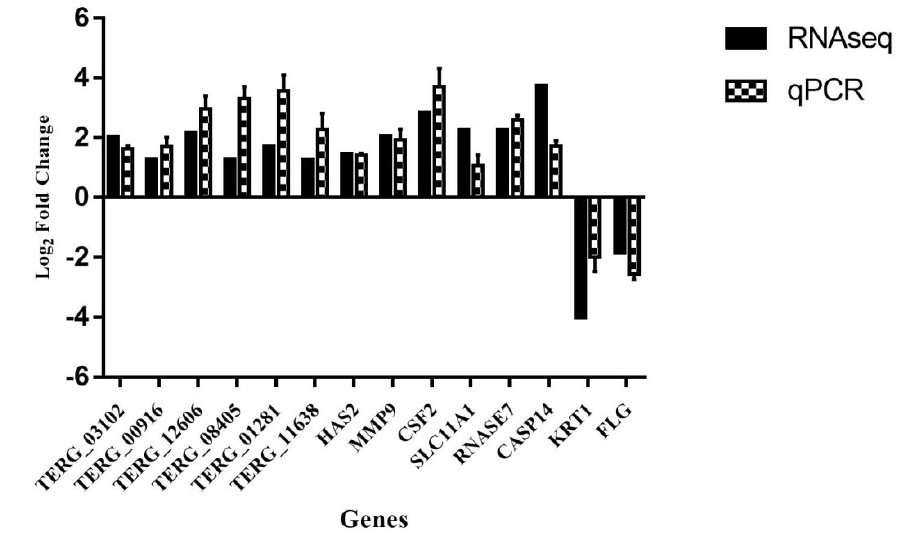
Figure 3. The comparison of gene modulation obtained by RNA-seq and quantitative PCR (qPCR) . The error bars represent the standard error of three independent replicates. Pearson’s test indicated a strong correlation between the two techniques (r = 0.80; p < 0.01).